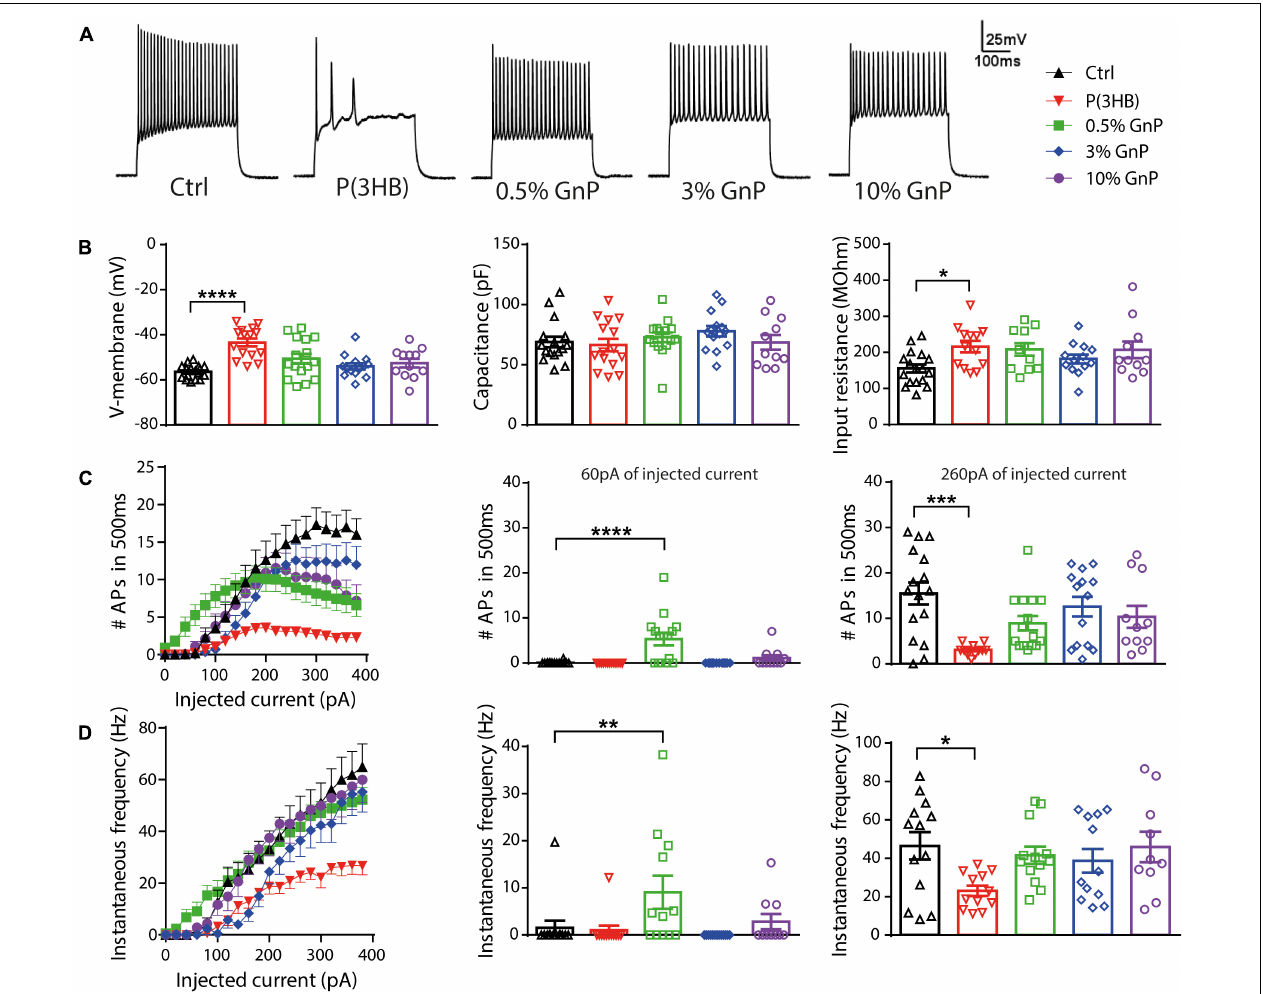
FIGURE 3 | Firing properties of primary cortical neurons plated on P(3HB)/GnP composites. Neurons were plated at increasing GnP concentrations (0.5, 3.0, and 10.0% GnP) and under two control conditions [glass and P(3HB)] for 14 days. (A) Representative whole-cell current-clamp traces of action potentials (APs) evoked by the injection of 260 pA current step are shown. (B) Resting membrane potential [left, n = 17, 15, 16, 14, and 12 for Ctrl, P(3HB), 0.5, 3.0, and 10.0% GnP, respectively], capacitance [center, n = 16, 15, 15, 14, and 11 for Ctrl, P(3HB), 0.5, 3.0, and 10.0% GnP, respectively], and input resistance [right, n = 17, 13, 11, 13, and 11 for Ctrl, P(3HB), 0.5, 3.0, and 10.0% GnP, respectively] are shown. (C) The mean number of APs in 500 ms as a function of the injected current (left) and the mean firing frequency at 60 pA (center) and 260 pA (right) injected current are shown [ n = 16, 13, 15, 14, and 11 for Ctrl, P(3HB), 0.5, 3.0, and 10.0% GnP, respectively]. (D) Instantaneous frequency as a function of the injected current (left) and at 60 pA (center) and 260 pA (right) injected current are shown [ n = 13, 12, 13, 13, and 10 for Ctrl, P(3HB), 0.5, 3.0, and 10.0% GnP, respectively]. 0.5% GnP displayed a significant enhancement in both instantaneous and mean frequency compared to the glass controls. In addition, no significant differences between composite samples and glass controls were found. On the contrary, neurons plated on the P(3HB) support showed a reduced frequency of evoked APs. Data are expressed as means ± SEM; Kruskal-Wallis and Dunn’s post hoc tests, from two independent neuronal preparations. * p < 0.05; ** p < 0.01; *** p < 0.001; **** p <